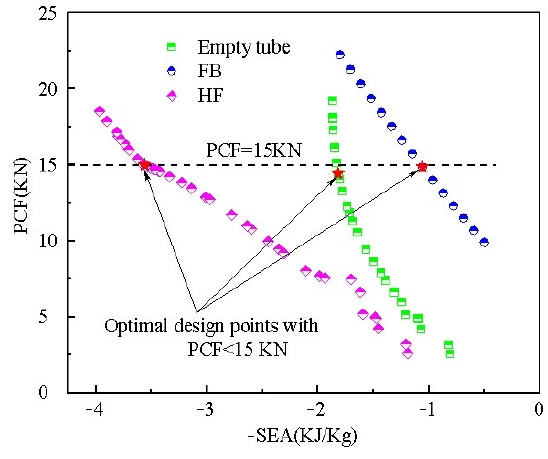
Figure 13. Comparison of the Pareto boundary of FB, HF and empty tube.